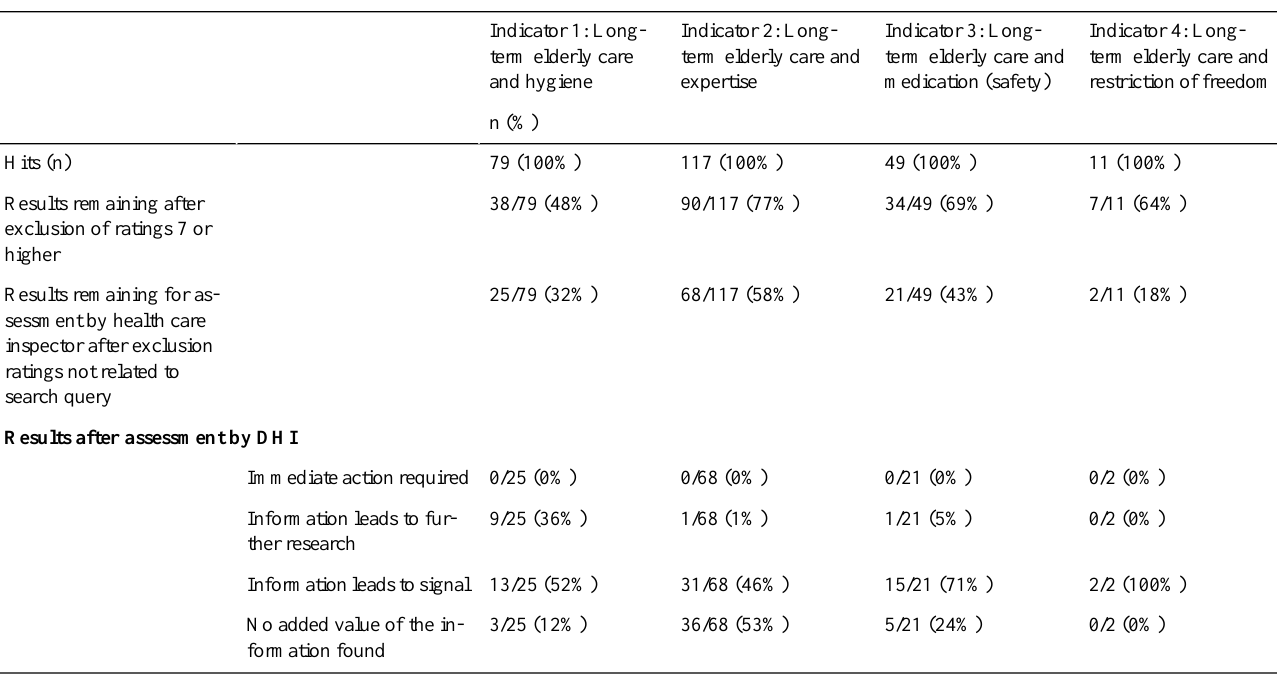
Table 2. Added value of information for risk-based